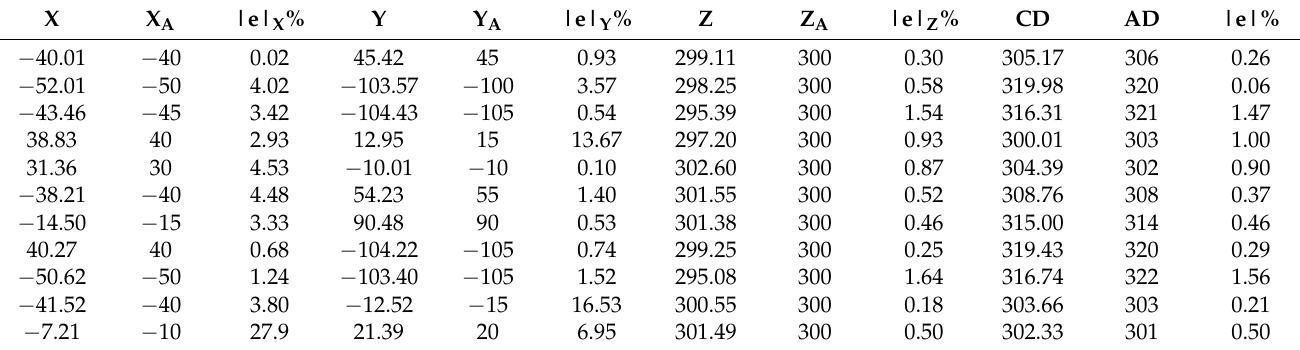
Table 5. Binocular camera ranging results when Z = 300 (unit: